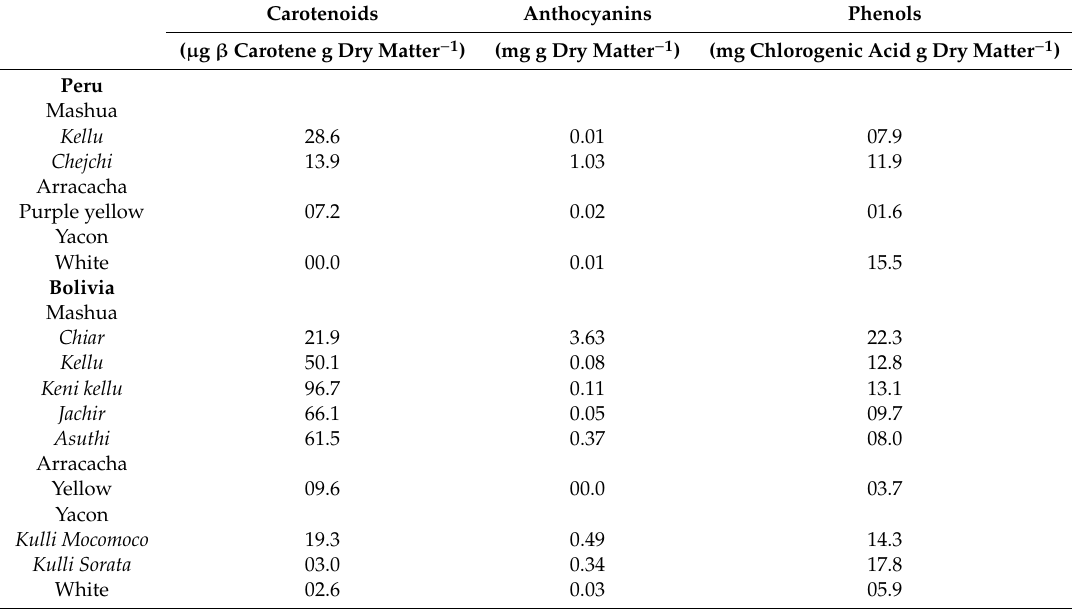
Table 5. Concentration of carotenoids, anthocyanins, phenols, and glucosinolates in Andean root and tuber